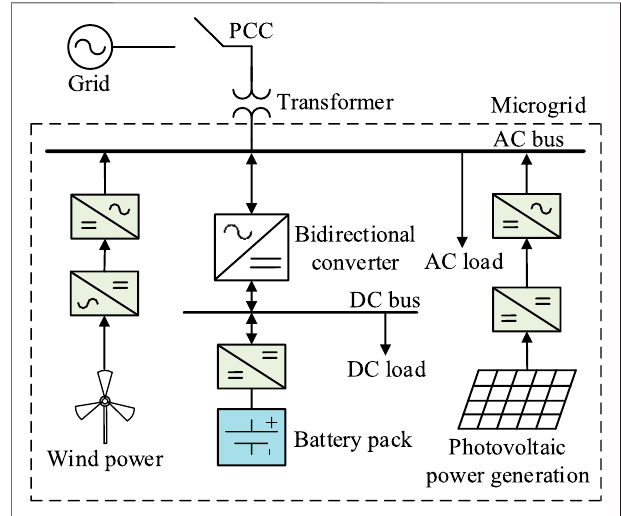
FIGURE 1 | Schematic diagram of the island microgrid